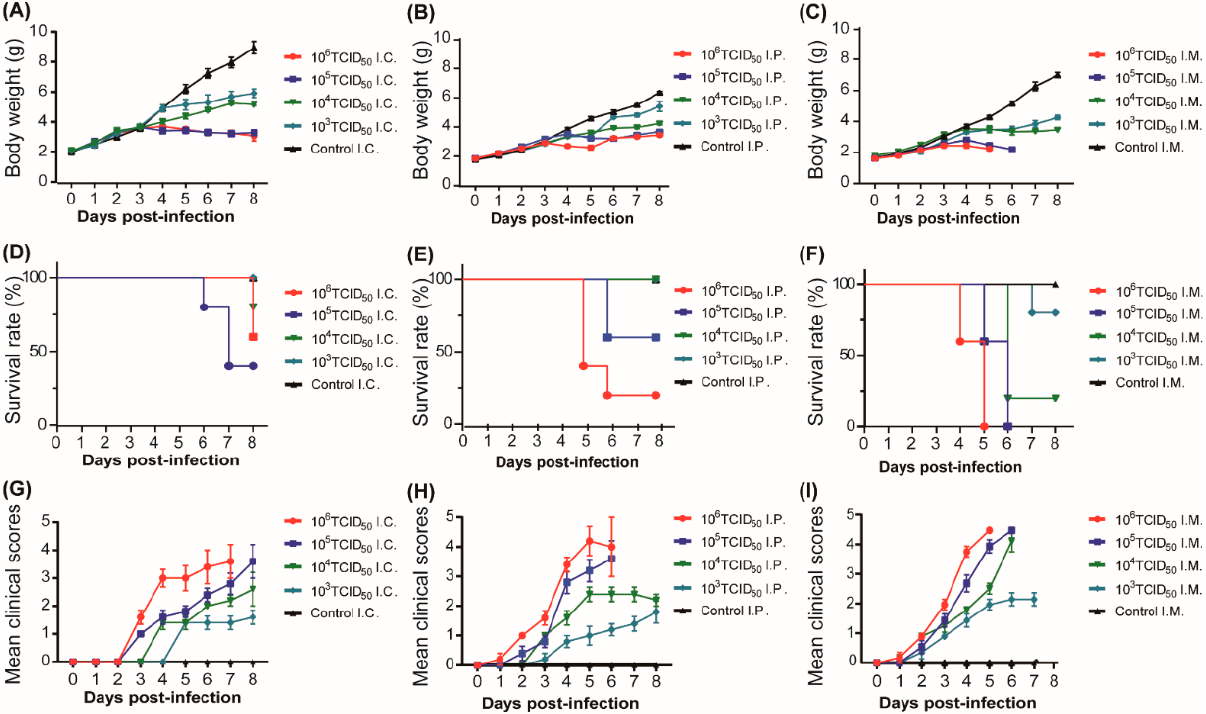
Figure 1. Body weight, survival rate, and clinical score of suckling mice in inoculation route and virus challenge dose experiments. Five-day-old ICR mice were infected with strain F219 at 10 3 , 10 4 , 10 5 , and 10 6 TCID 50 by intracranial injection ( A , D , G ), intraperitoneal injection ( B , E , H ), and intramuscular injection ( C , F , I ), respectively ( n = 7 per group); control mice were inoculated with cell culture maintenance medium (MM). Body weight ( A – C ), survival rate ( D – F ) and clinical scores ( G – I ) of 5-day-old mice inoculated via IC, IP, and IM were monitored daily. Clinical scores of CVA6- infected and control mice. 0, no disease; 1, ruffled fur; 2, weight loss; 3, single limb paralysis; 4, hindlimb paralysis; 5, moribund or dead.